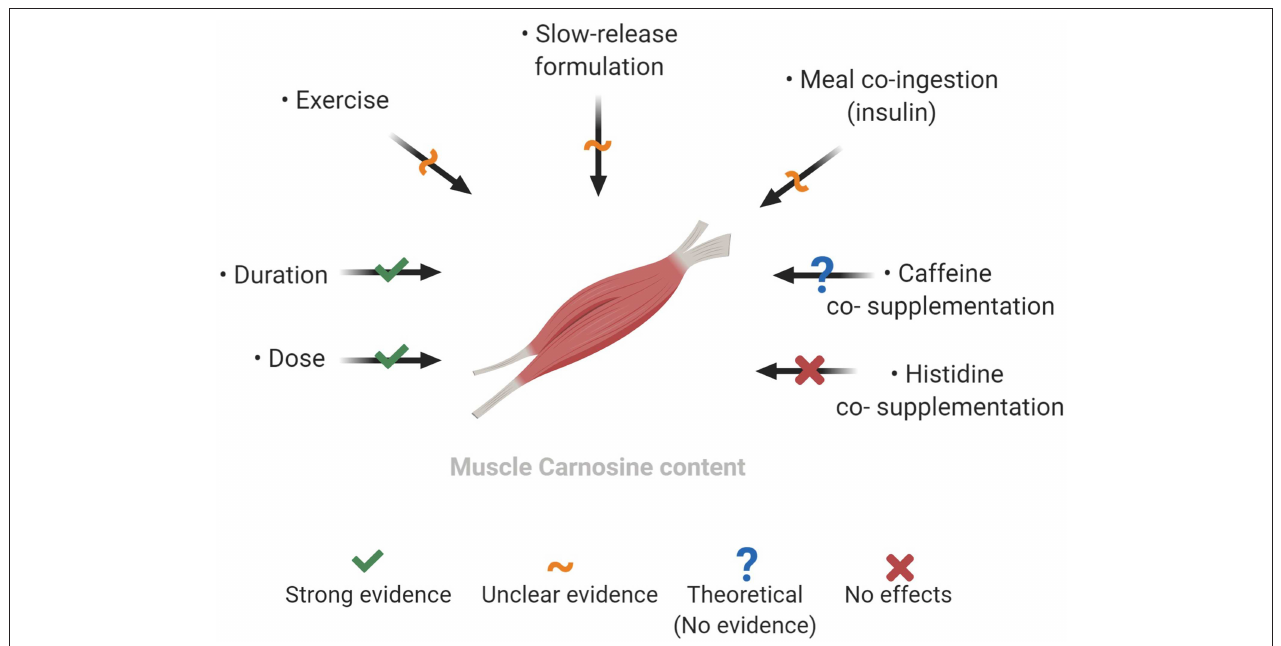
FIGURE 2 | Factors which may modify the increases in muscle carnosine content with beta-alanine supplementation. Created with BioRender.